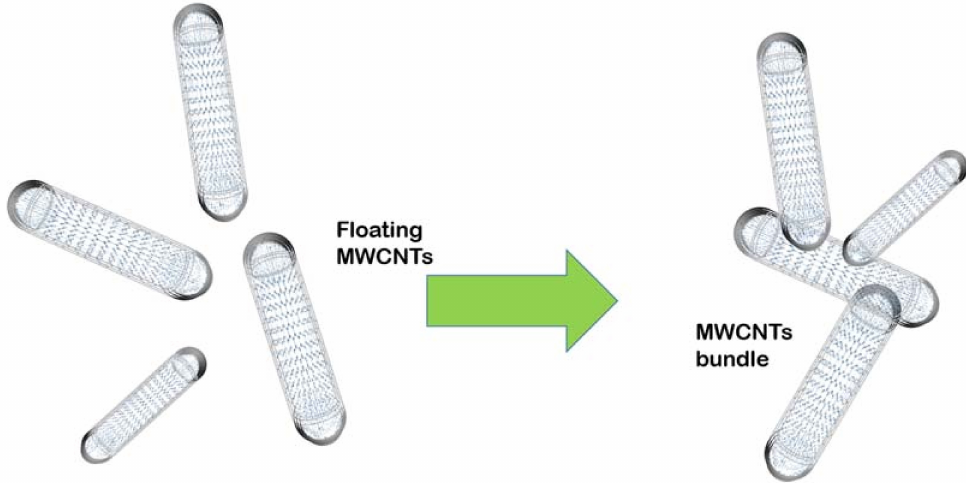
Figure 8. Concept chart of the formation of the MWCNT